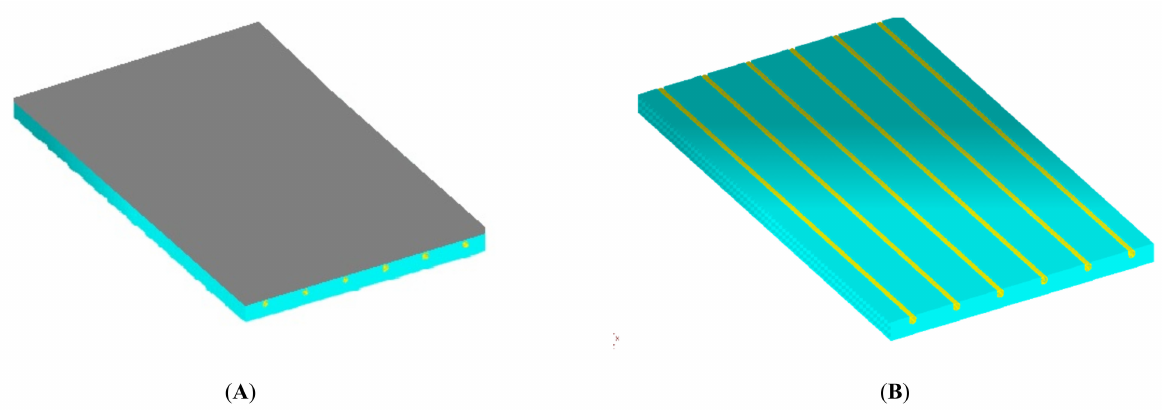
Figure 18. The 3D visualization of the model: ( A ) sample with an adhesive, ( B ) location of heating pipes.